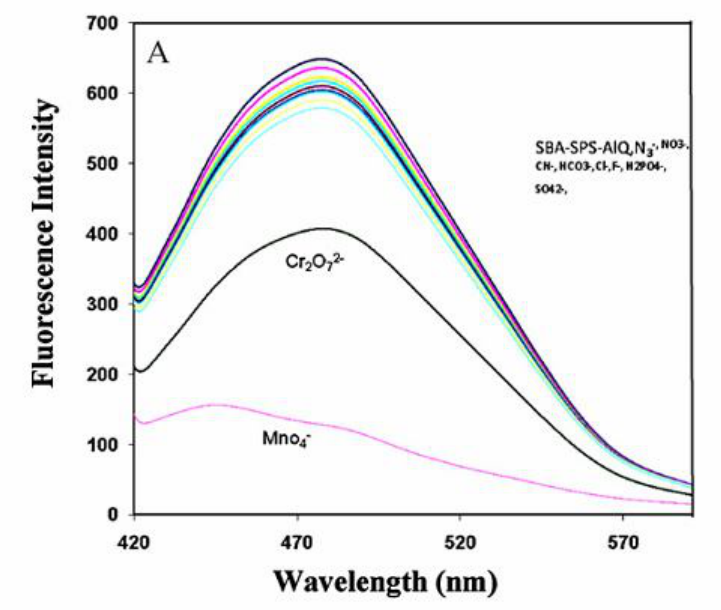
Fig. 6. Fluorescence emission spectra of SBA-SPS-AlQ